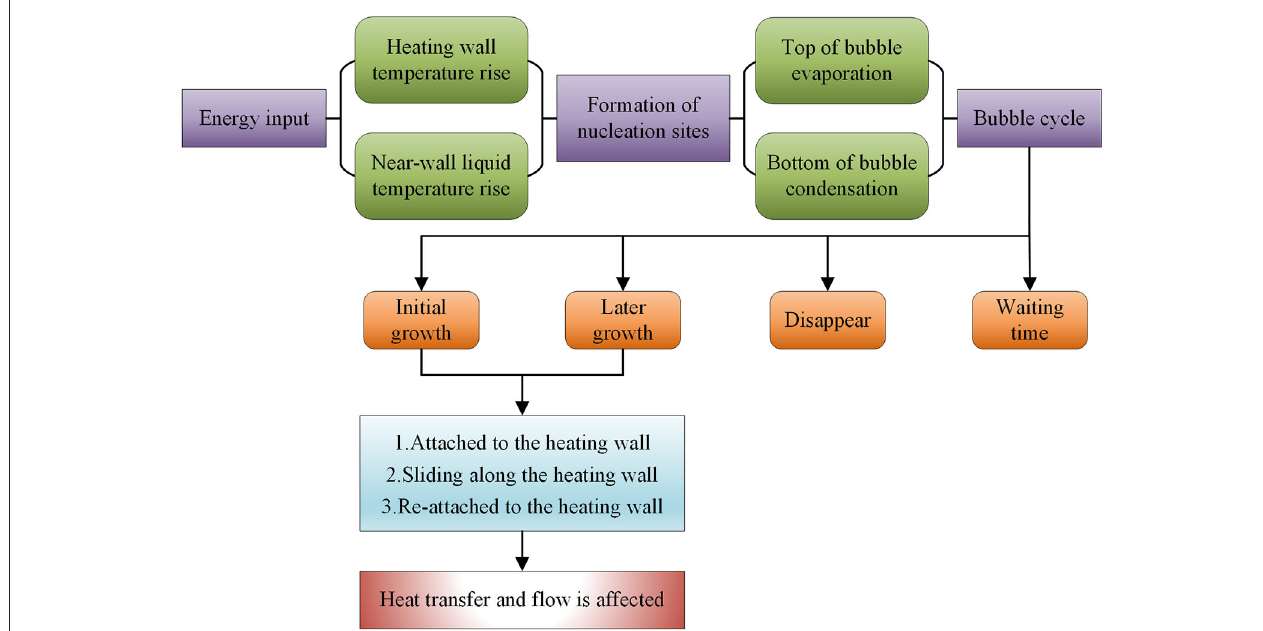
FIGURE 5 | The cycle of single sliding bubble.